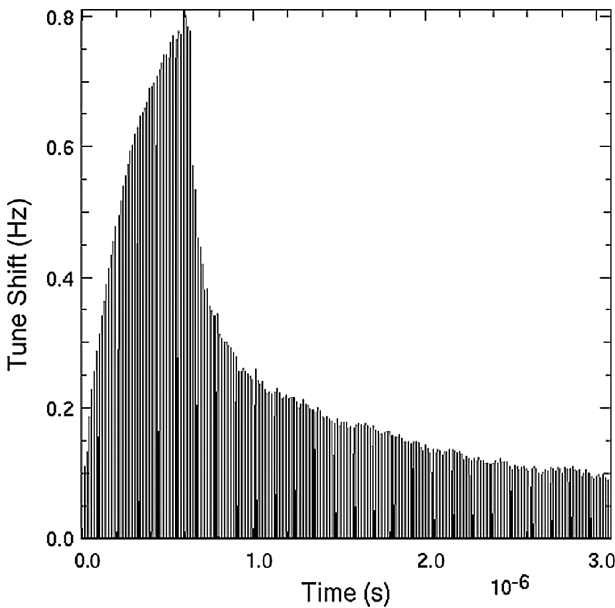
FIG. 17. Tune shift vs position of the center of the beam bunch, z0, for the first 20 bunches of the train (note: contribution of 1st bunch is very small so on this scale its curve lies along the horizontal axis). The field nulls are at z ¼ 0 : 0 , 0.2, 0.4 m. Maxima of B y are at z ¼ 0 : 1 , 0.3